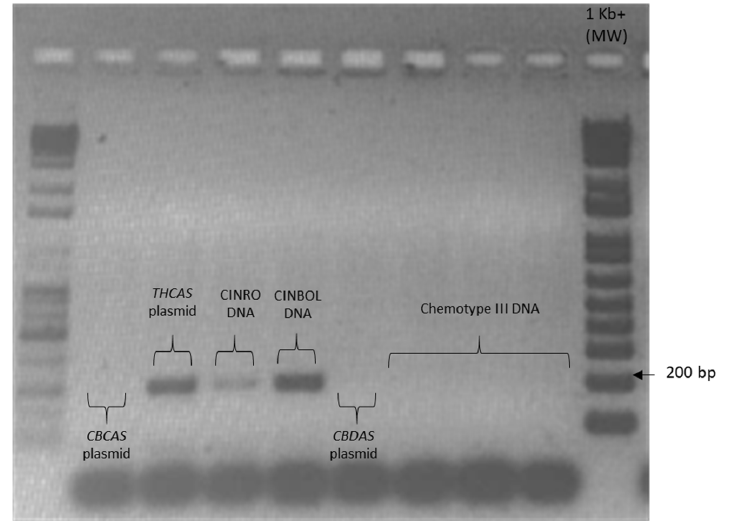
Figure A2. Specificity of primers for THCAS . The expected amplification band of 198 bp was obtained from pJET1.2 containing the THCAS and DNA of CINRO and CINBOL. Amplification was not obtained from pJET1.2 plasmid containing the CBCAS , and the CBDAS , and neither using DNA from hemp varieties as template.